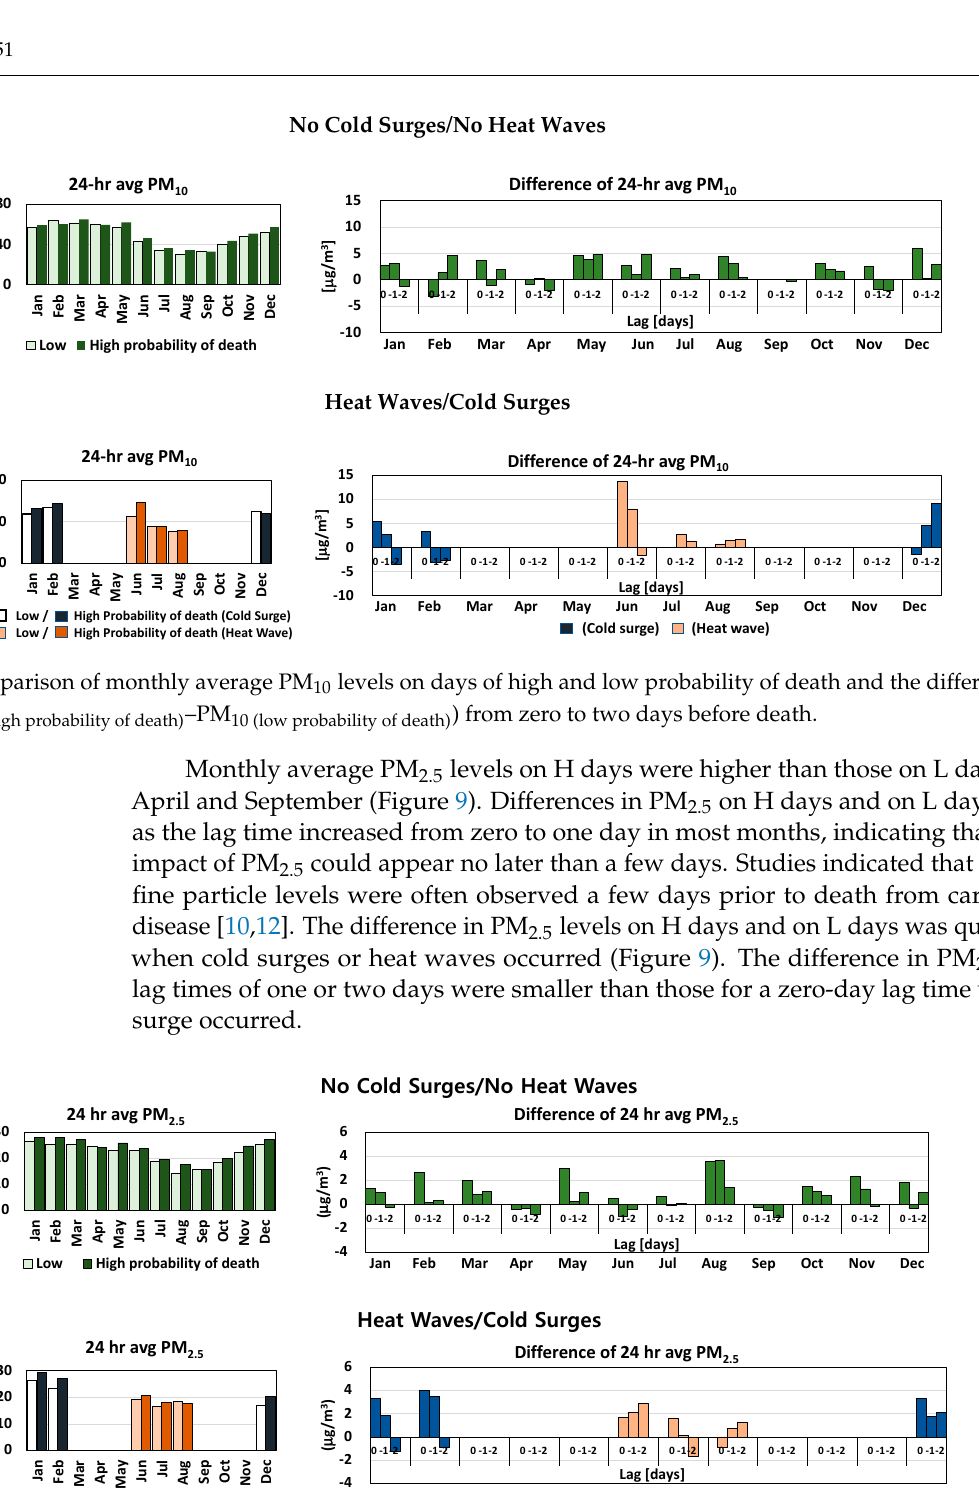
Figure 9. Comparison of monthly average PM 2.5 levels on days of high and low probability of death and the differences in